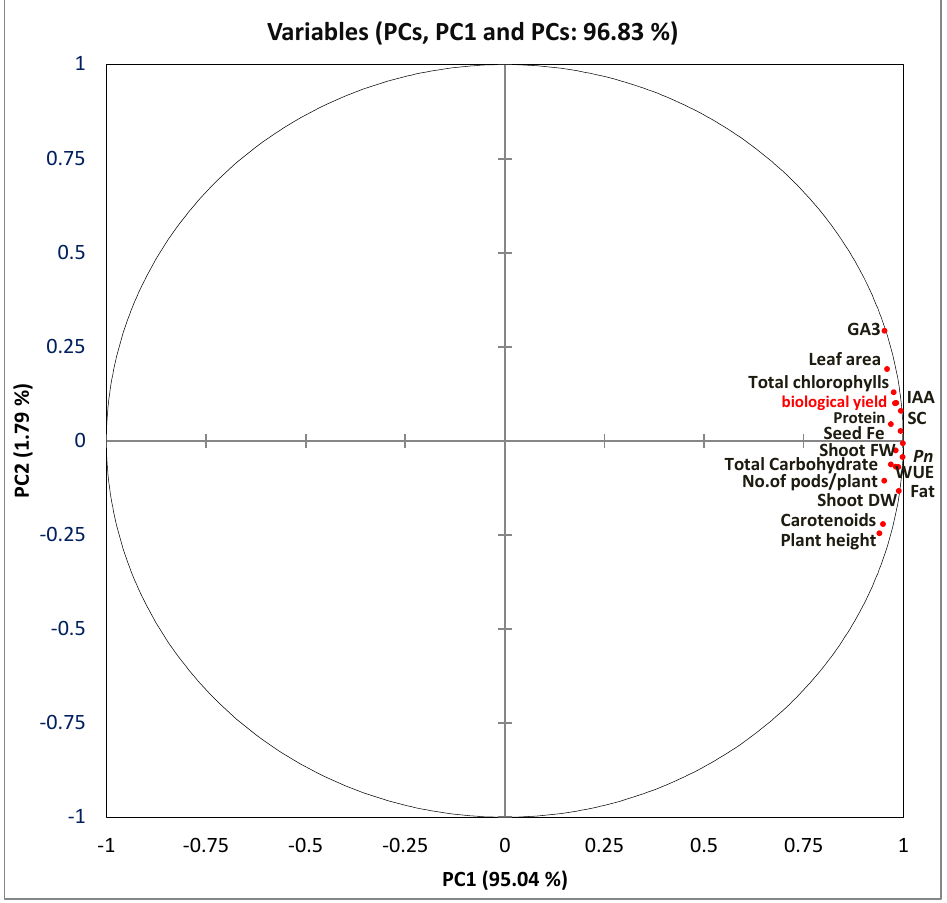
Figure 5. Principal component analysis of agro-physiological and biochemical properties of broad bean plants sprayed with the diverse form of iron fertilizers (nano, chelate, and sulfate).